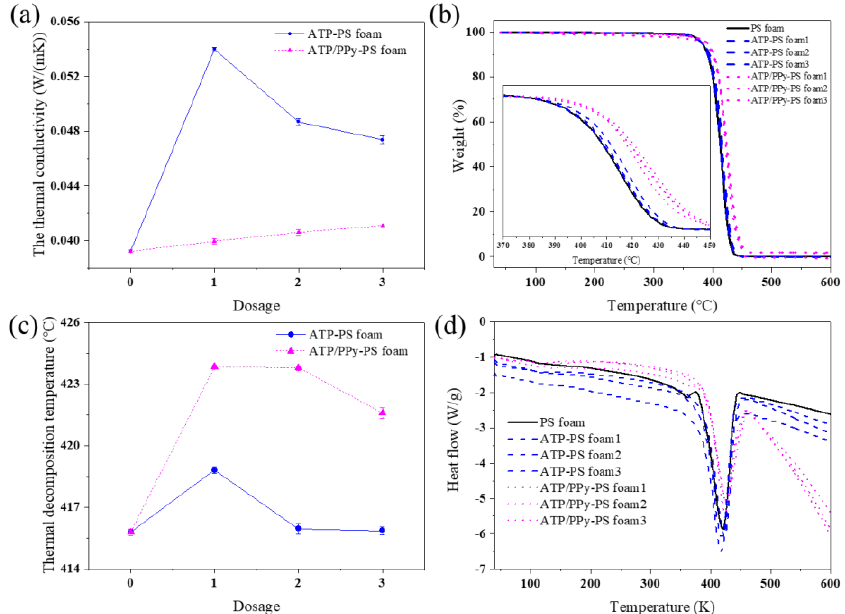
Figure 5. ( a ) Thermal conductivity, ( b ) thermogravimetric analysis (TGA, the partial curves within the temperature range of 370–450 °C were zoomed in as shown in the inset), ( c ) thermal decomposition temperature (TDT) and ( d ) differential scanning calorimetry (DSC) analyses of neat PS foam, ATP-PS foams, and ATP/PPy-PS foams, respectively.